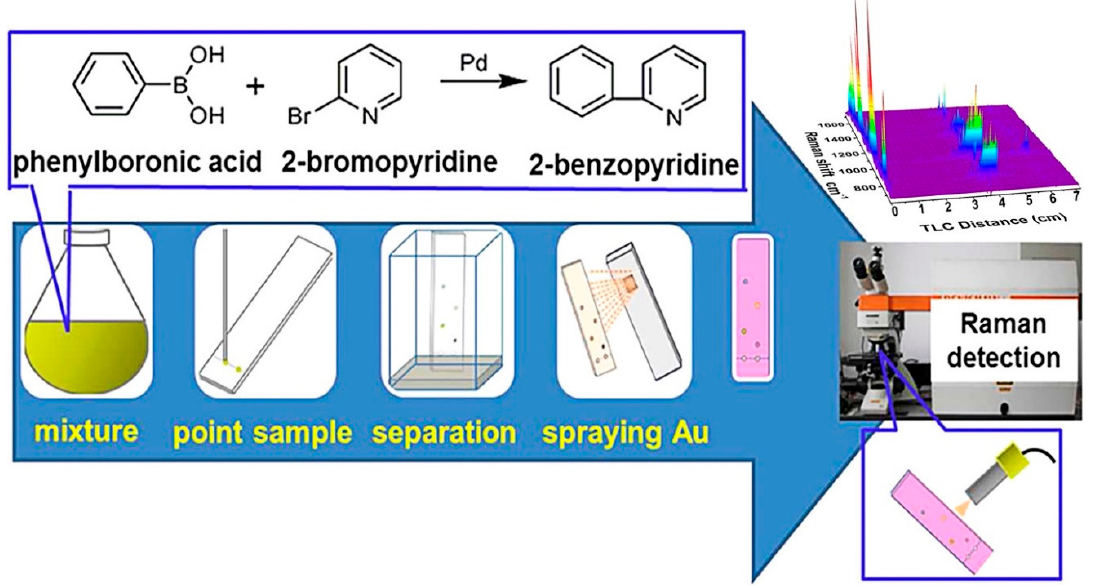
Figure 1. On-site quantitative monitoring of organic reaction by TLC-SERS. Reprinted with permis- sion from ref. [49]; Copyright 2014 American Chemical